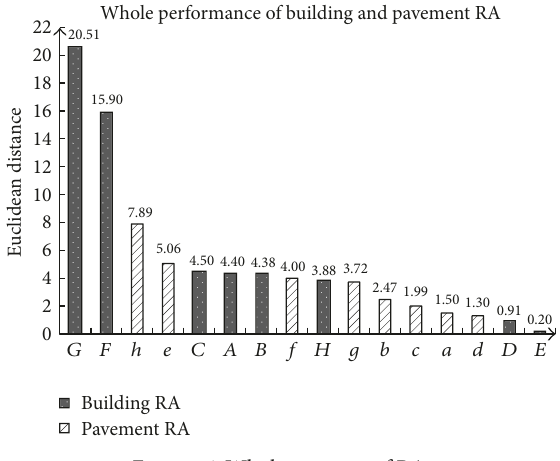
Figure 6: Whole property of